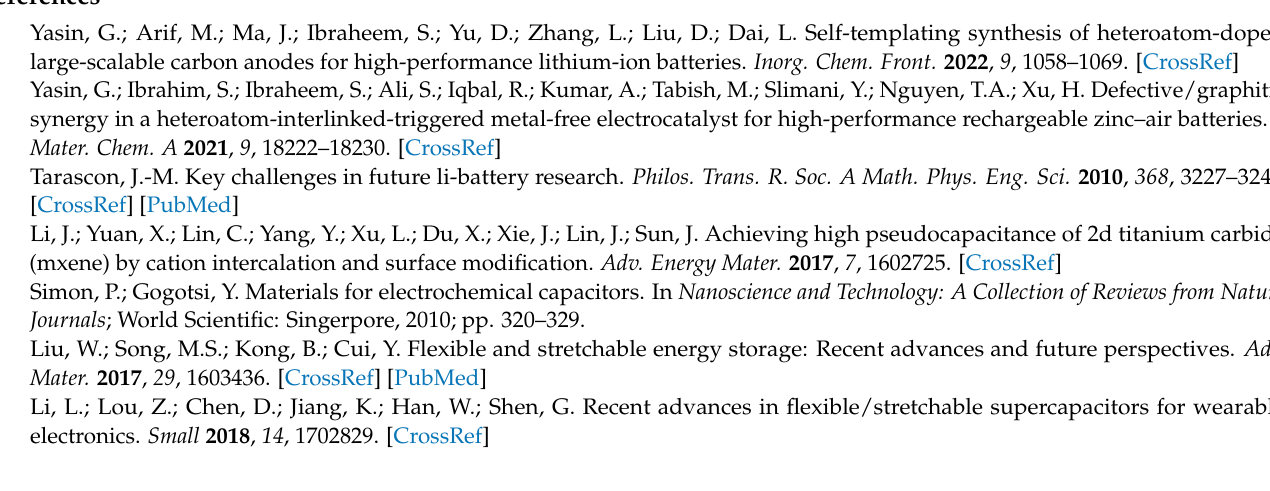
equivalent circuit model Figure S8: Nyquist plots of symmetric SC of Mxene. Figure S9: The survey spectra of Mxene film Figure S10: Graph between the peak current densities of all the tested electrodes Vs square root of Scan Rate. Figure S11: Specific capacitance of MXene and MX/AuNPs electrode and Symmetric SCs vs. the scan rate., Figure S12: Ragone plots displaying energy and power densities